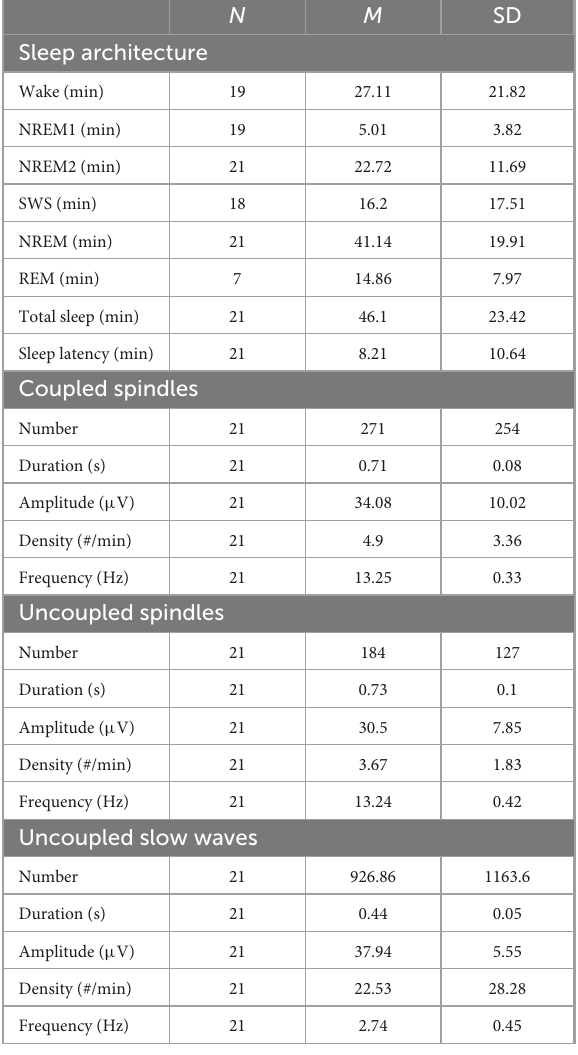
TABLE 1 Sleep architecture and spindle parameters for coupled and uncoupled spindles during EEG–fMRI